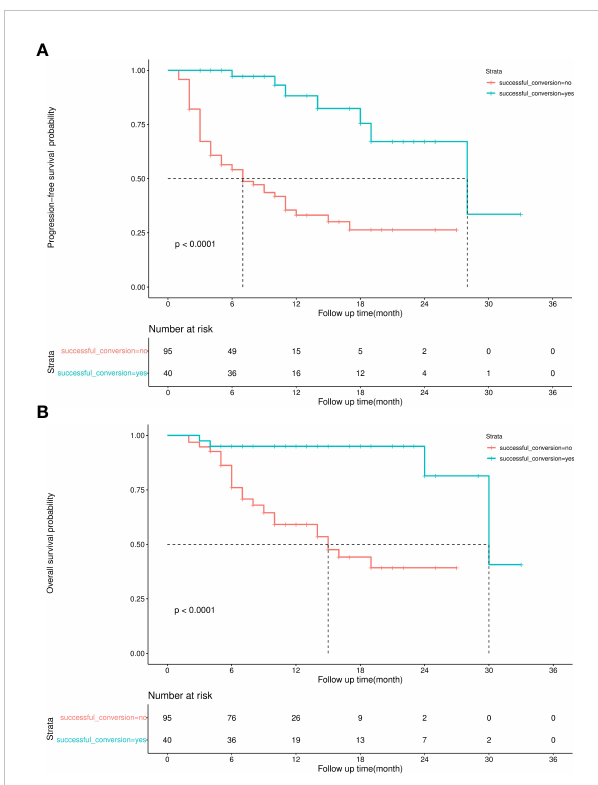
FIGURE 4 (A) Kaplan – Meier curve for progression-free survival, (B) Kaplan – Meier curve for overall survival.